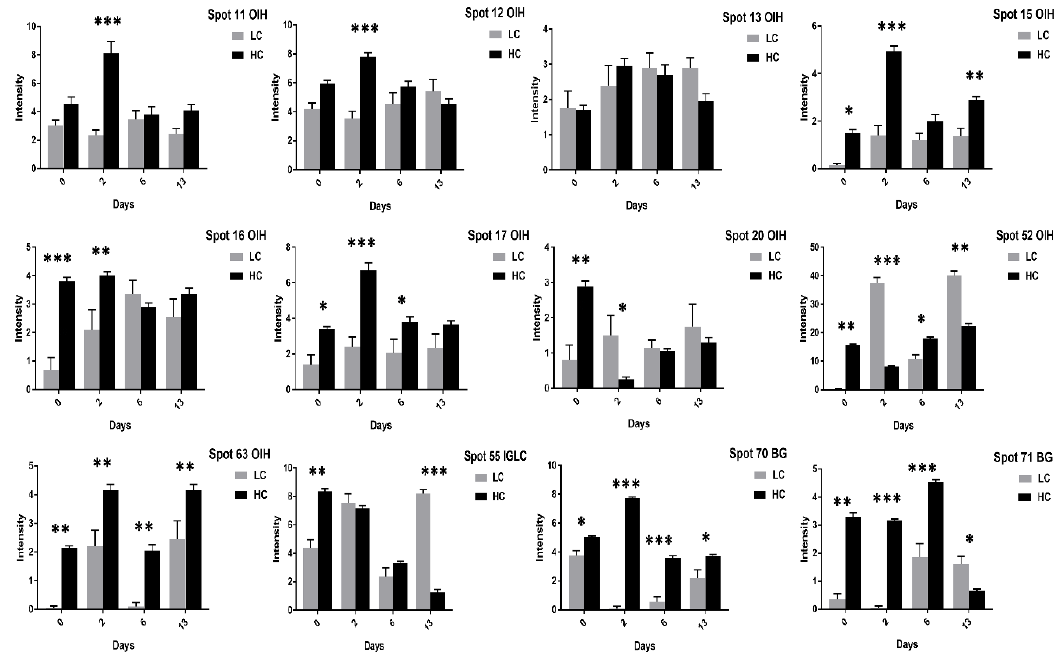
Figure 14. Comparison of OIH, IGLC and BG proteins spots after 0, 2, 6, and 13 days of incubation was shown in high and low cholesterol eggs. The column profiles of OIH (11–13, 15–17, 20, 52, 63), IGLC (55) and BG (70, 71) are shown as bar charts with significant differences. The values are from three independent replicates and the error bars represent the standard deviation. * p < 0.05, ** p < 0.005, *** p < 0.0001. Animals 2021 , 11 , x FOR PEER REVIEW